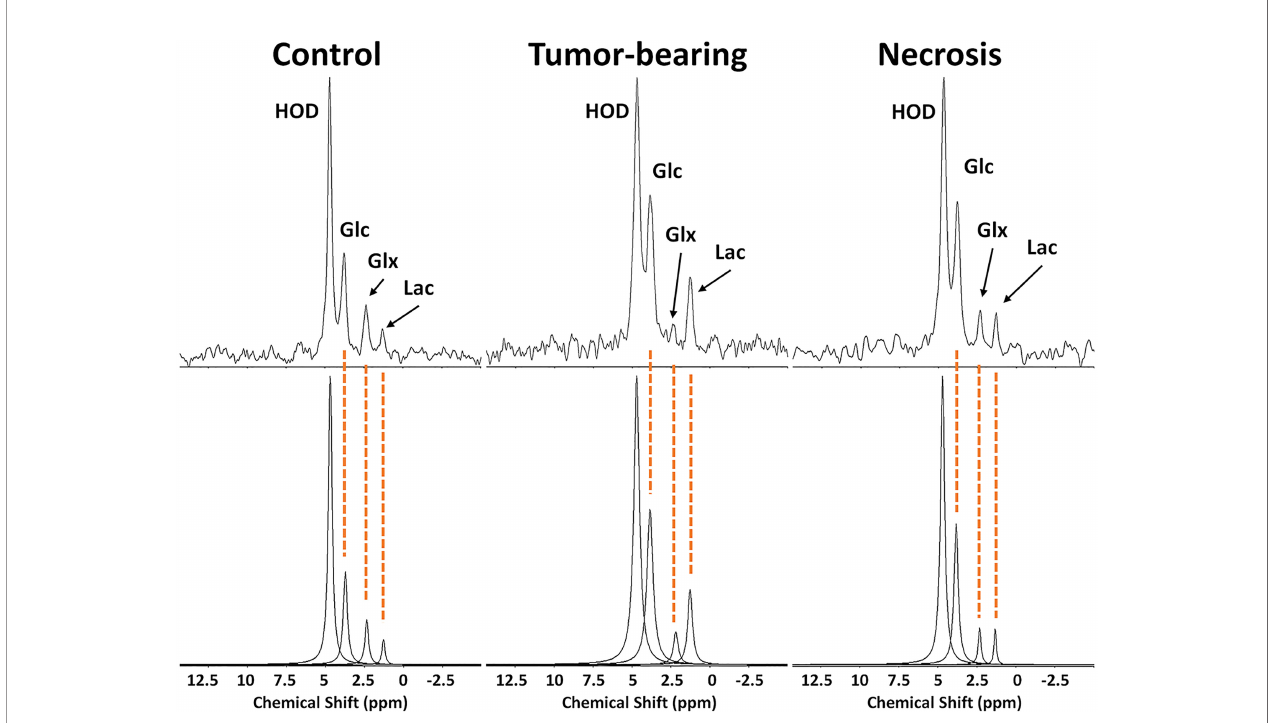
FIGURE 8 | (top) 2 H MR spectra created by summation of nine 10-min acquisitions during administration of Glc for (left) control, non-lesion-bearing mouse; (middle) pure tumor; (right) pure radiation necrosis. (bottom) Results of Bayesian modeling of these spectra. Estimates and uncertainties of resonance frequencies, amplitudes, and linewidths derived from decay-rate constants (R2*) for these spectra are summarized in Supplementary Data, Table S1 .